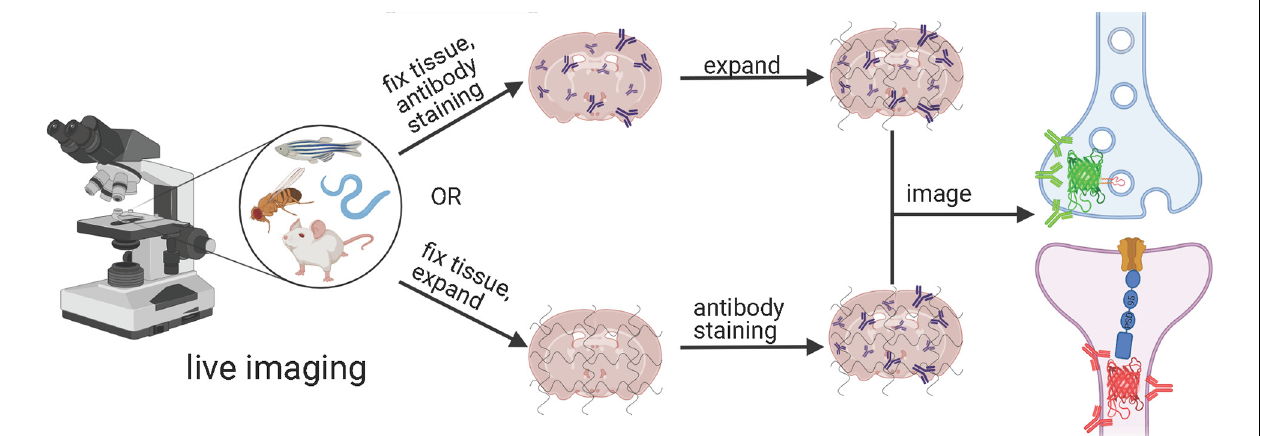
FIGURE 5 | Generalized workflow for combining tools to exogenously label post-synaptic and pre-synaptic neurons in a variety of model organisms with expansion microscopy. Created with